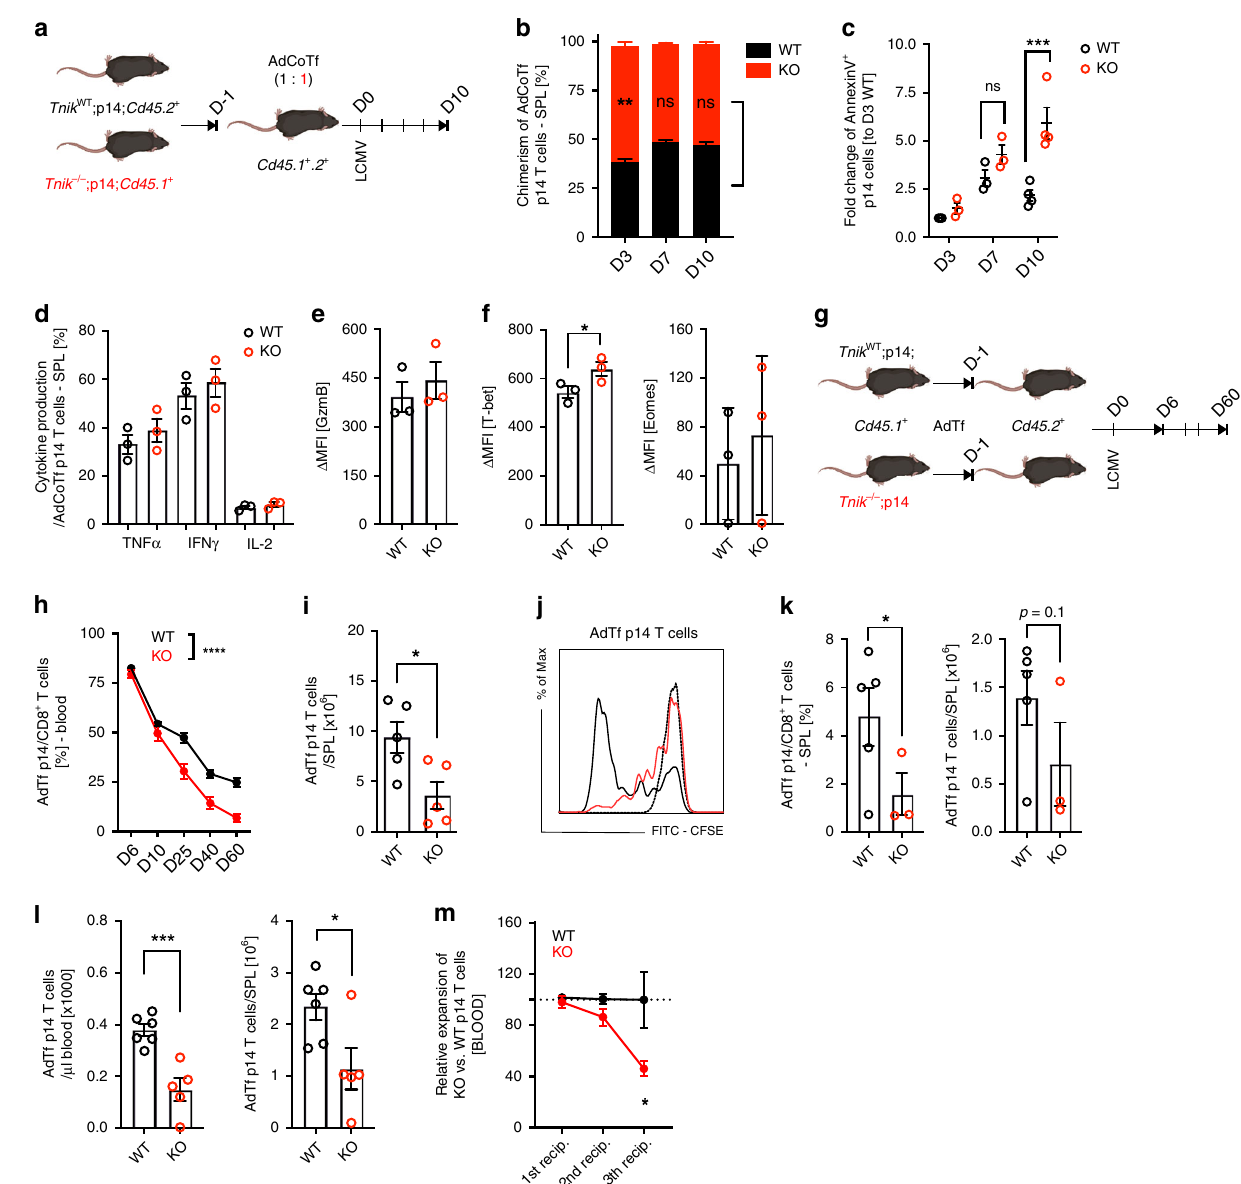
Fig. 3 Impaired memory formation of TNIK-de fi cient gp33-speci fi c CD8 + T cells. a Competitive AdTf (AdCoTf) model: 1 × 10 5 splenic Tnik WT (WT; Cd45.2 +